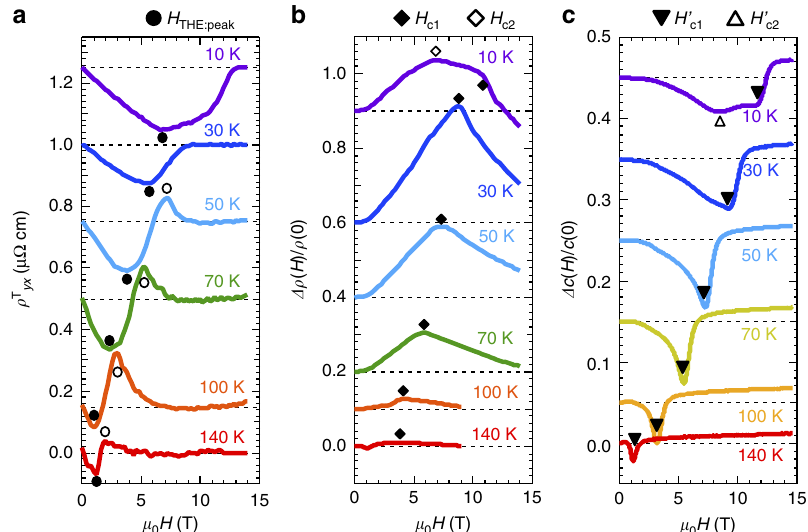
Figure 3 | Experimental results on temperature development of transport and elastic properties. Magnetic-field dependences of topological Hall resistivity ( a ), longitudinal MR ( b ) and change in elastic constant with propagation directions parallel to the magnetic field ( c ). Characteristic magnetic fields are marked as closed circles (negative peaks of topological Hall resistivity representing the maximal emergent magnetic field | b z |; H THE:peak ), open circles (positive peaks of topological Hall resistivity near the phase boundary), closed diamonds (peak in MR originating from fluctuations around phase boundary; H c1 ), open diamond (a peak in MR around the extremal- f z point; H c2 ), closed triangles (negative peaks in elastic constant originating from fluctuations around the phase boundary; H 0 ) and open triangle (a kink in elastic constant around the extremal- f z point; H 0 ). c1 c2